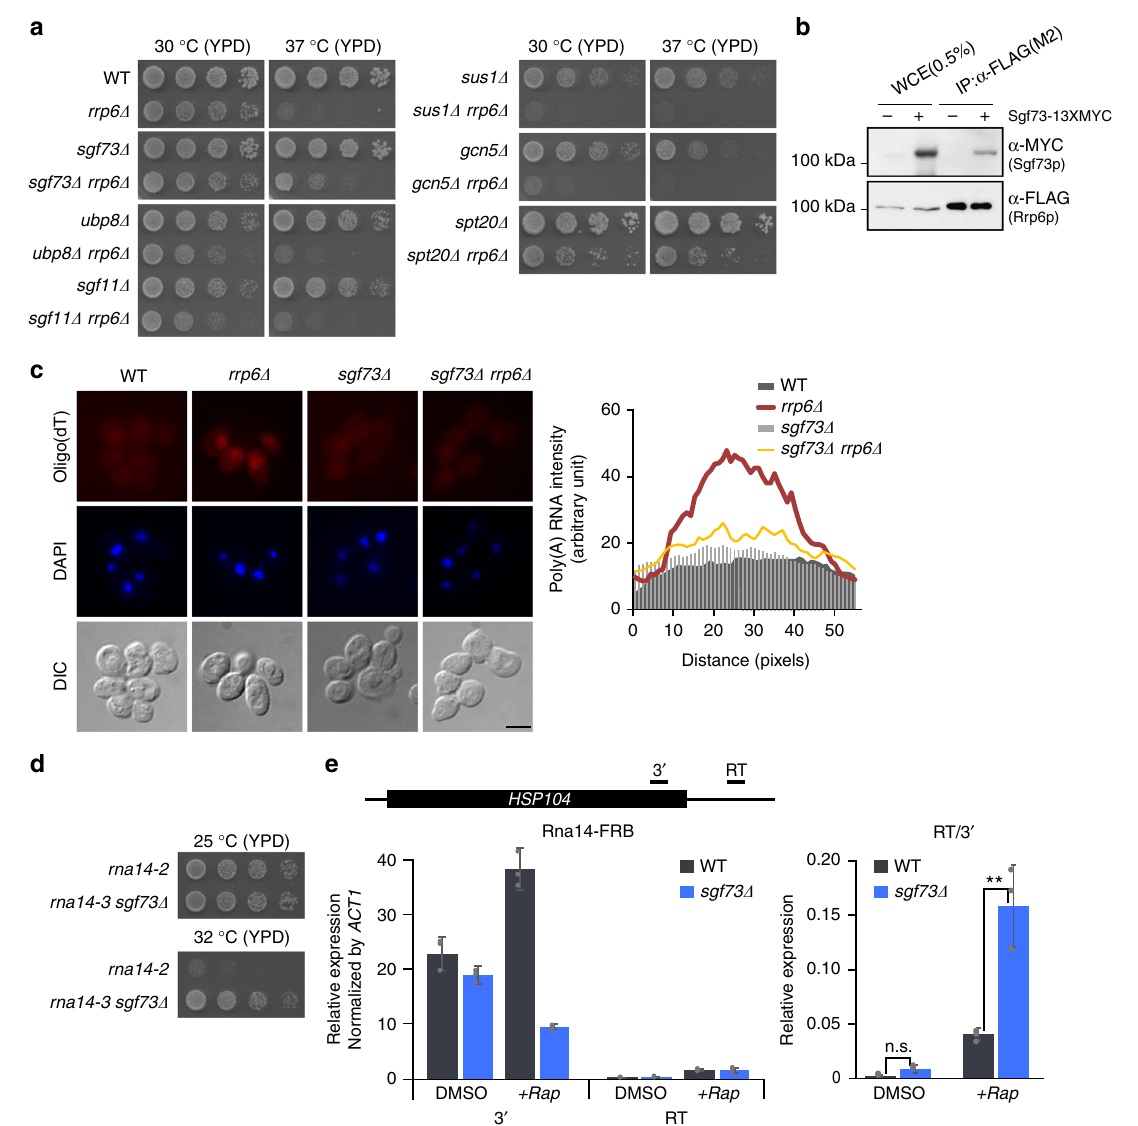
Fig. 2 Sgf73p functions in mRNP quality control. a Spotting assays to assess genetic interactions between rrp6 Δ and SAGA subunit-deletion mutants. Cells were spotted onto YPD plates with fi ve-fold serial dilutions and incubated at 30 and 37 °C. b Co-IP assay of Sgf73p ( α -MYC) and Rrp6p ( α -FLAG). Rrp6p ( α -5xFLAG) was immobilized on anti-FLAG M2 af fi nity gel and co-IP was assessed by Western blotting. c (Left panel) FISH analyses of wildtype, rrp6 Δ , sgf73 Δ , and sgf73 Δ rrp6 Δ cells. Poly-(A) + RNA was detected using Cy3-labeled oligo(dT) probes and DNA was counterstained with DAPI. Scale bar, 5 μ m. (Right panel) Quanti fi cation graph of poly-(A) + RNA intensity. Poly-(A) + RNA intensity was quanti fi ed using the same scan width of respective nuclei (determined by DAPI staining). d Spotting assays to assess the genetic interaction between rna14-3 and sgf73 Δ . Cells were spotted onto YPD plates with fi ve-fold serial dilutions and incubated at 25 and 32 °C. e Quanti fi cation of read-through transcripts from the HSP104 gene in wildtype and sgf73 Δ cells. Wildtype and sgf73 Δ cells were depleted of Rna14p using the anchor-away method ( + Rap ). Levels of read-through transcripts were normalized by 3 ′ - transcripts. Standard deviations of three independent experiments are shown by error bars and P -values were determined by Student ’ s t -test (* P ≤ 0.05, ** P ≤ 0.01, and *** P ≤ 0.001). WCE, whole cell extract. RT,